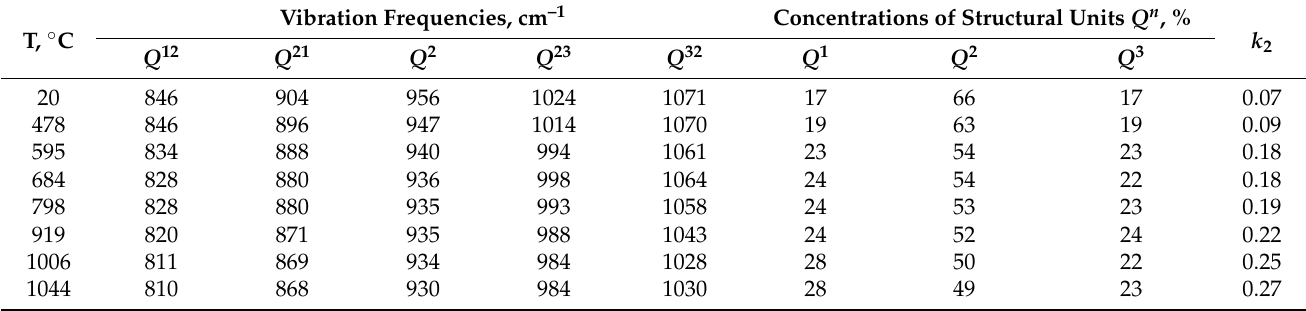
Table 2. Vibration frequencies, concentrations of structural units and equilibrium constants of Reaction (1) at n = 2 in glasses and melts of the potassium silicate sample with 50 mole per cent of potassium oxide at various